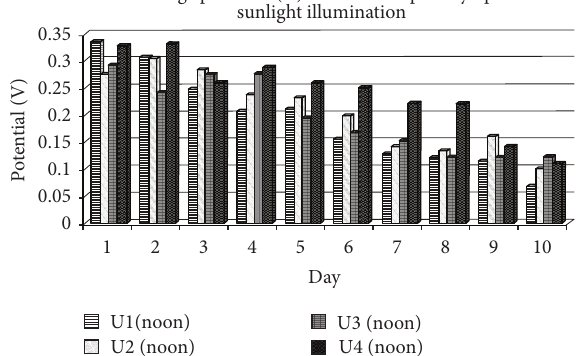
Figure 15: Graph of the average values of potential (V) at afternoon (3-4pm) upon sunlight illumination for ten days where respective cell; metal oxide; U1 and U2 (without and with additive, resp.), treated metal oxide with ultrasonic; U3 and U4 (without and with additive,